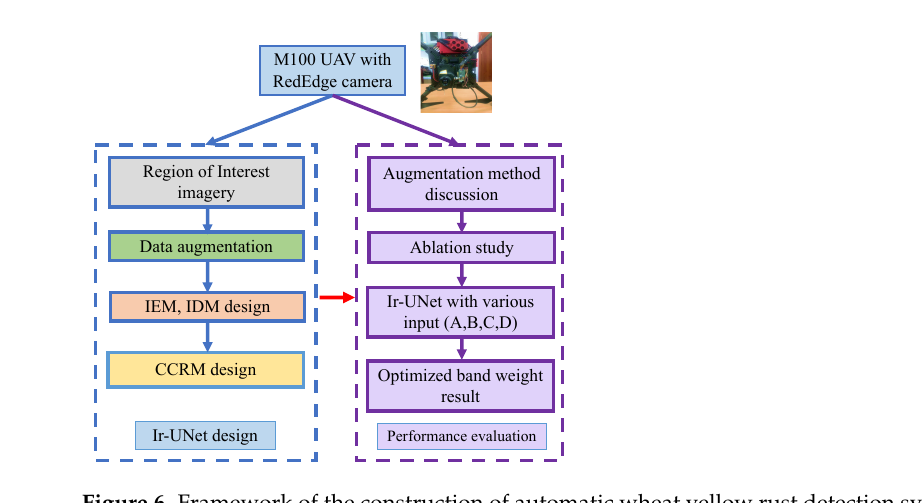
Figure 6. Framework of the construction of automatic wheat yellow rust detection system.